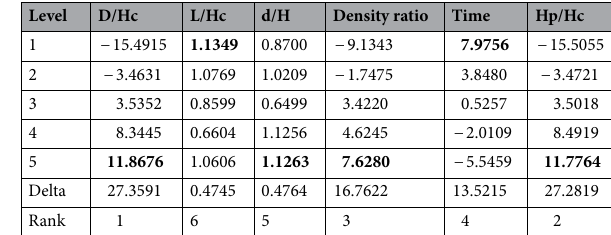
Table 11. Response for signal-to-noise ratios. (Larger is better). Significant values are in